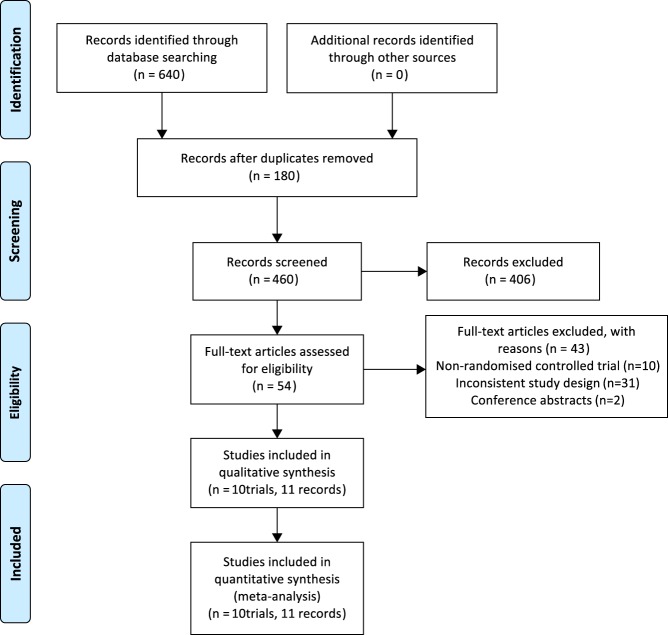
Flow diagram of literature search.